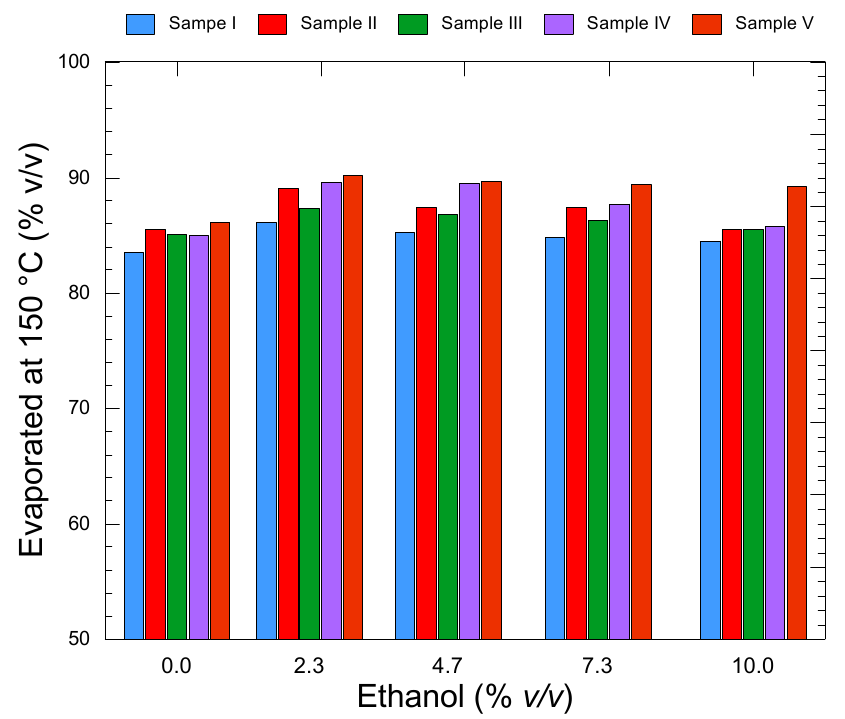
Figure 10. E150 values for all blends against bio-ethanol content.